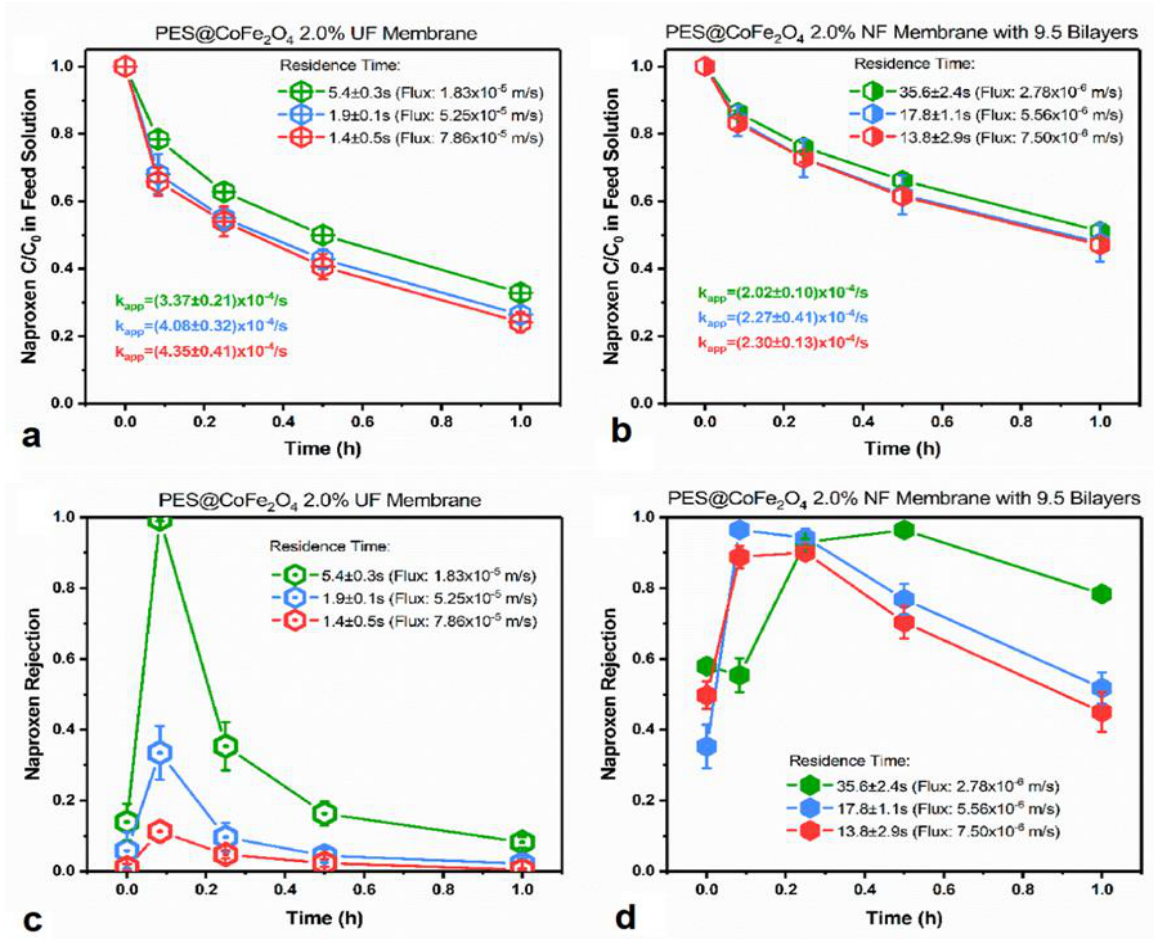
Figure 6. Effects of residence time on naproxen degradation and rejection: degradation by UF ( a ) and NF ( b ) membranes; rejection by the UF membrane ( c ) and the NF membrane ( d ). Reproduced with permission from [109], Copyright 2021 Elsevier.